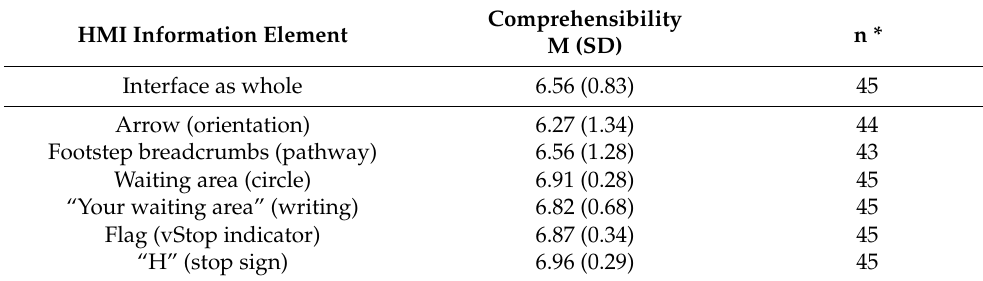
Table 4. Results of AR-element comprehensibility rating by participants of second user study during naïve run.